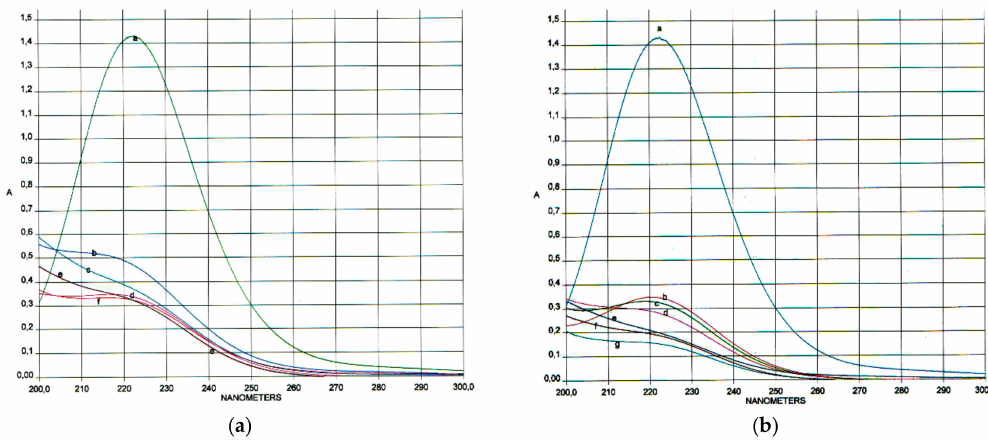
Figure 6. Absorption spectra of the reaction mixture: ( a ) T = 45 ◦ C at various times (t, h): (a) 0; (b) 3; (c) 6; (d) 9; (e) 12; (f) 18; ( b ) T = 80 ◦ C at various times (t, h): (a) 0; (b) 0.25; (c) 0.5; (d) 0.75; (e) 1.0; (f) 1.25; (g) 1.5.